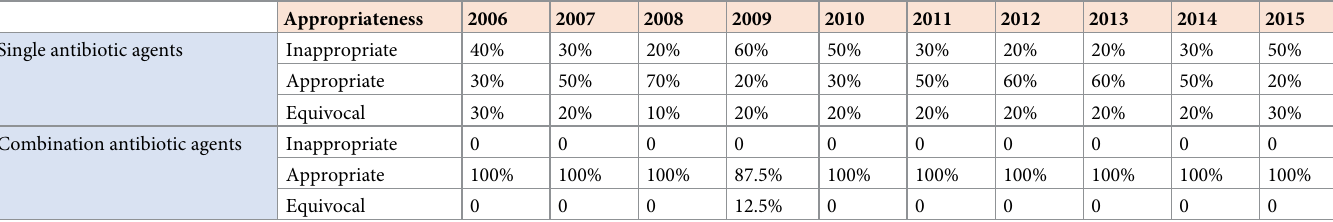
Table 2. Proportion of antibiotics categorized as appropriate, inappropriate and equivocal in HAUTIs.